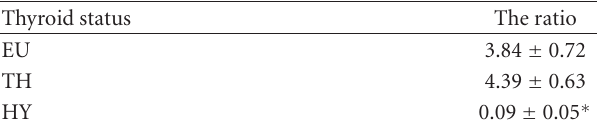
Table 1: Ratio of cardiac MyHC α /MyHC β isoforms from left ven- tricles of adult euthyroid (EU), hyperthyroid (TH), and hypothy- roid (HY) Lewis rats. MyHC isoforms were separated by SDS- PAGE, silver-stained, and quantified by densitometric evaluation (Quantity One Software, BioRad). The data are expressed as a mean ± SD, ∗ significantly di ff erent from EU and TH, P < 0 . 05, number of animals =